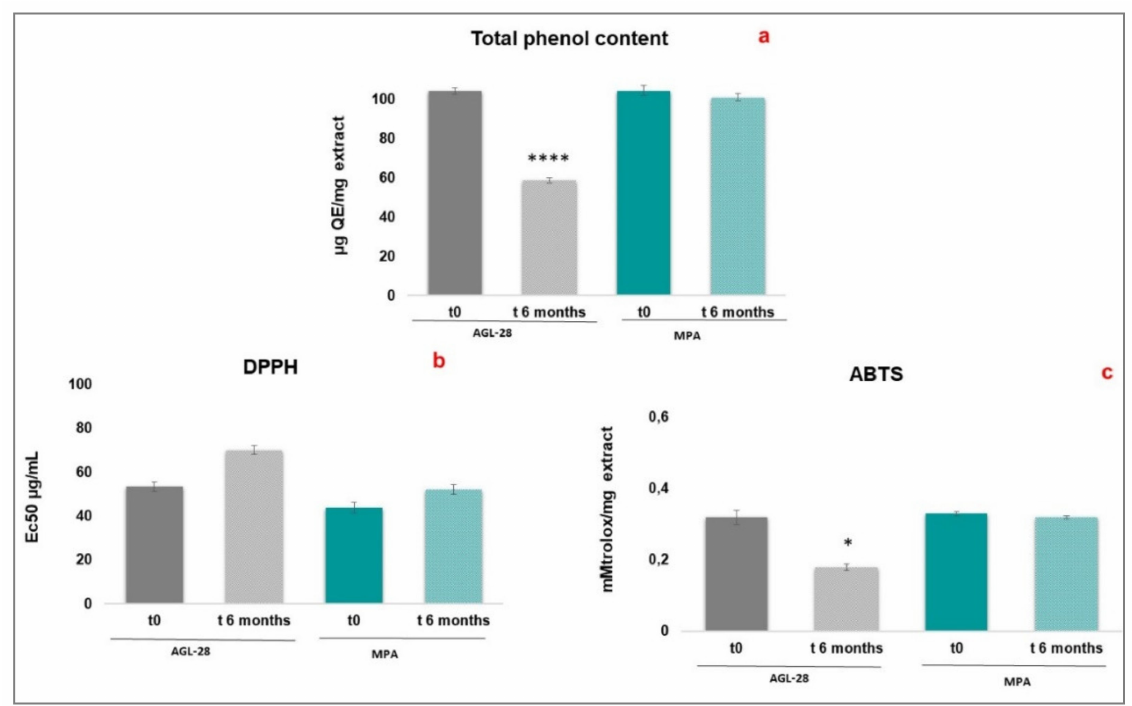
Figure 9. t -test, means ± SD, * p < 0.05 and **** p < 0.0001; ( a ) total phenol content; ( b ) EC50 ± standard deviation; In a unit of µ g of unprocessed AGL-28 or µ g of AGL-28 in MPA; ( c ) TEAC value ± standard deviation; TEAC value in unit of mM Trolox/mg of AGL-28 or mg of AGL-28 in